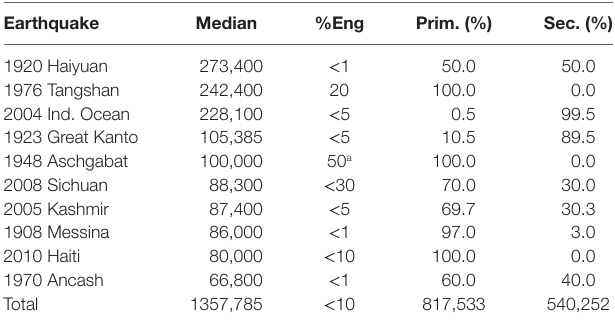
Table 7 | The top 10 earthquakes in terms of fatalities.